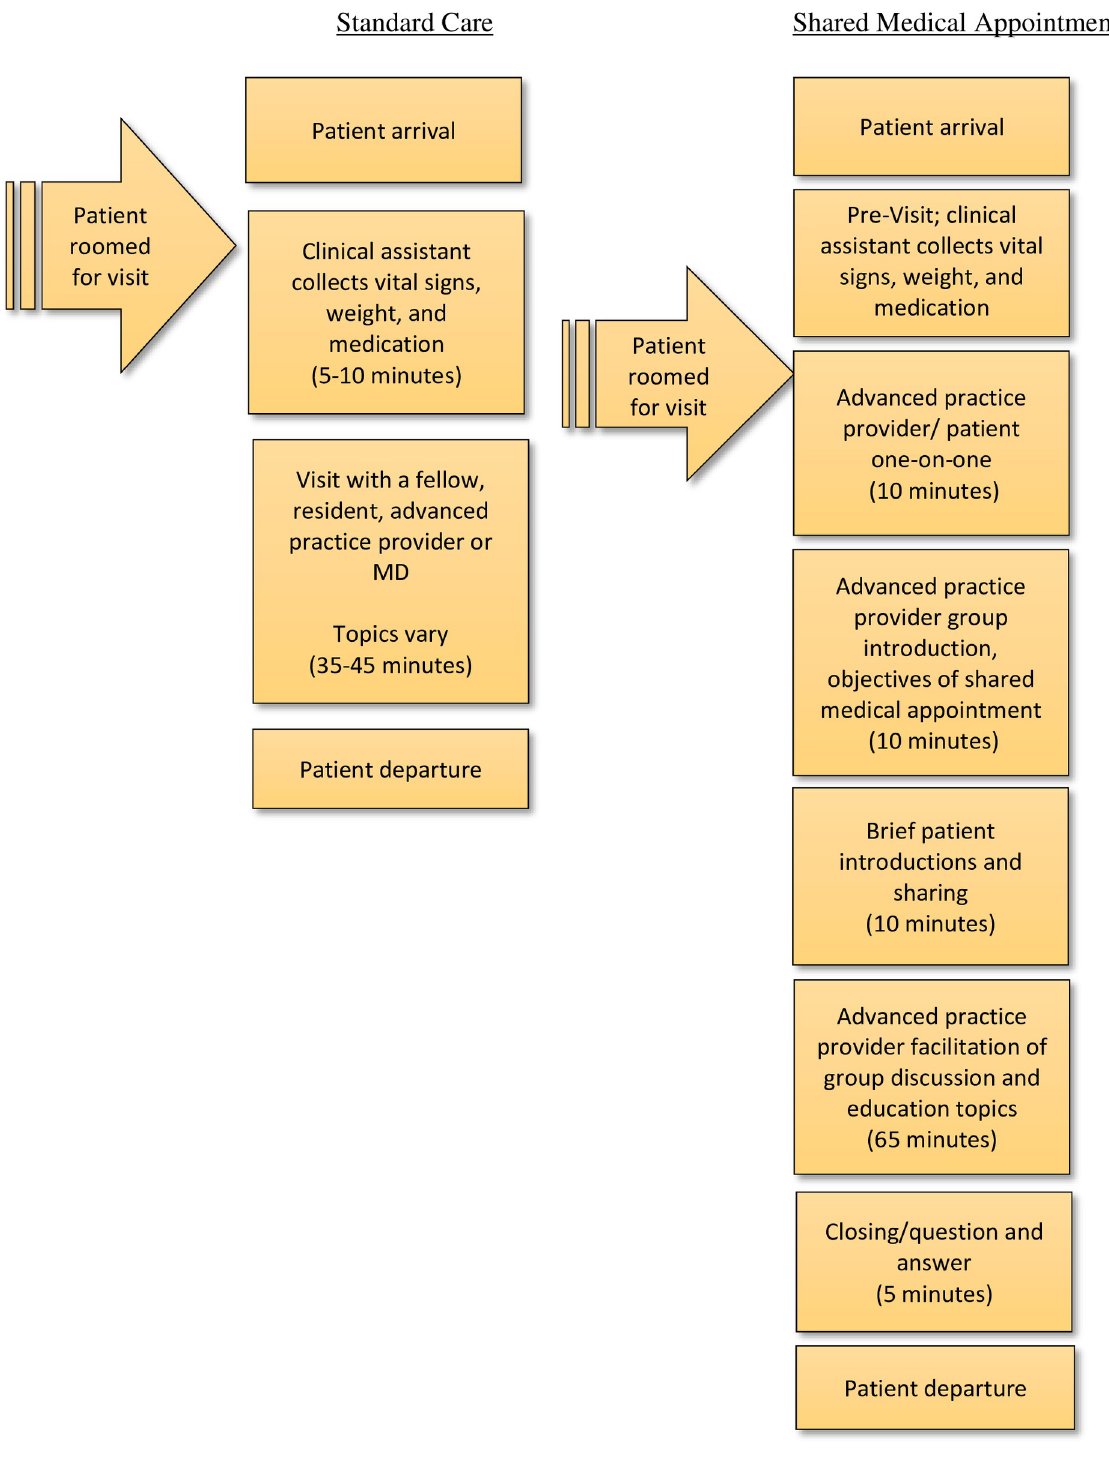
Fig 1. Pre-procedure and 3-month post-procedure visit flow for patients who underwent cardiac ablation.